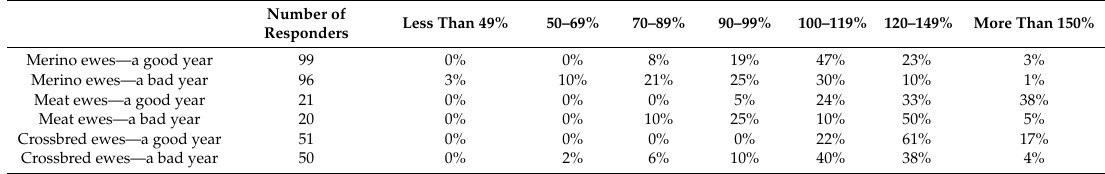
Table 5. Lamb marking rates (number of lambs weaned per 100 ewes joined) in good and bad years for Merino, Purebred Meat Breed, and Crossbred ewes as identified by NSW 137 sheep producers.